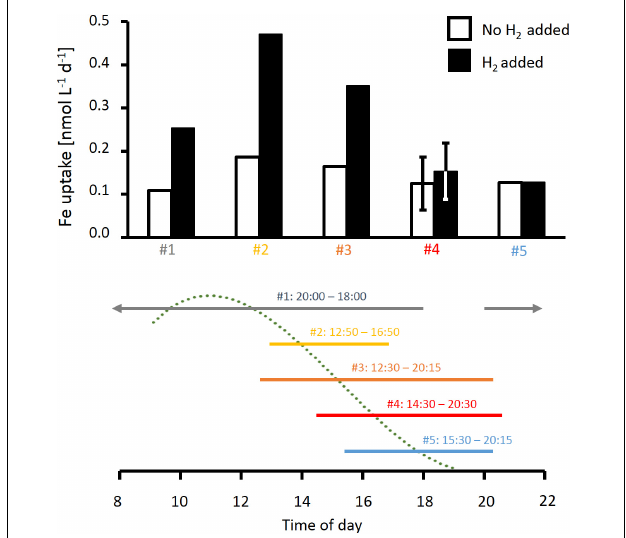
FIGURE 6 | Effect of H 2 on rates of iron uptake from ferrihydrite by natural Trichodesmium colonies measured at different times of the day. The time line below the plot indicates timing of the respective incubations as well as a typical diel cycle in N 2 fixation (dotted line), which was obtained by a third order polynomial fit to N 2 fixation rates measured in previous studies as specified in the legend of Figure 2 . Error bars for incubation #4 show standard deviation of two replicate samples. Note incubation #1 continued through the